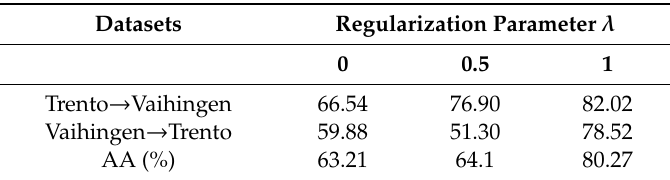
Table 11. Sensitivity analysis with respect to the regularization parameter for the EHR dataset. Results are expressed in terms of OS (%) and AA